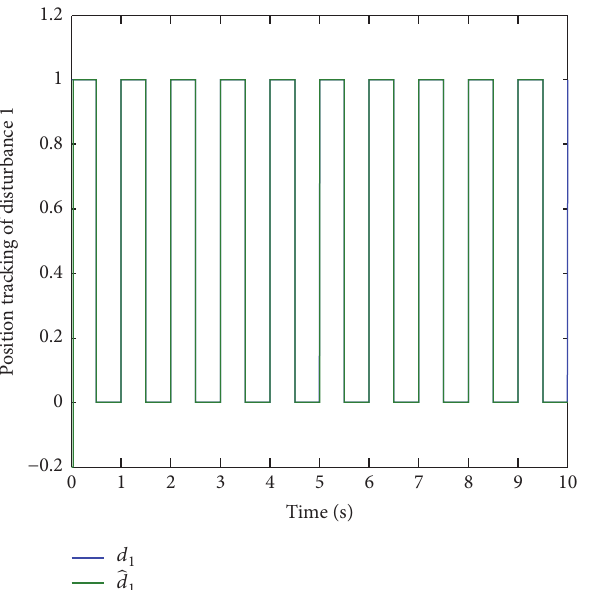
Figure 13: Actuator fault 𝑓 𝑎1 and its reconstruction value.